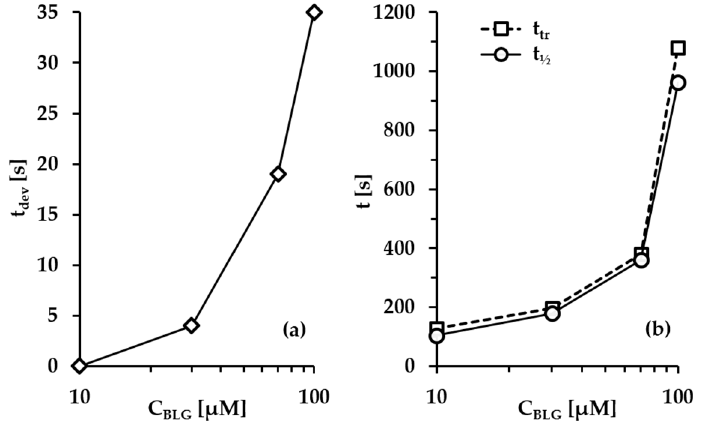
Figure 9. Characteristic times ( a ) t dev , ( b ) t ½ and t tr , of foam decay as a function of C BLG (pH 5, C buff = 10 mM). Lines are guides to the eye. Each data point is one foam experiment.